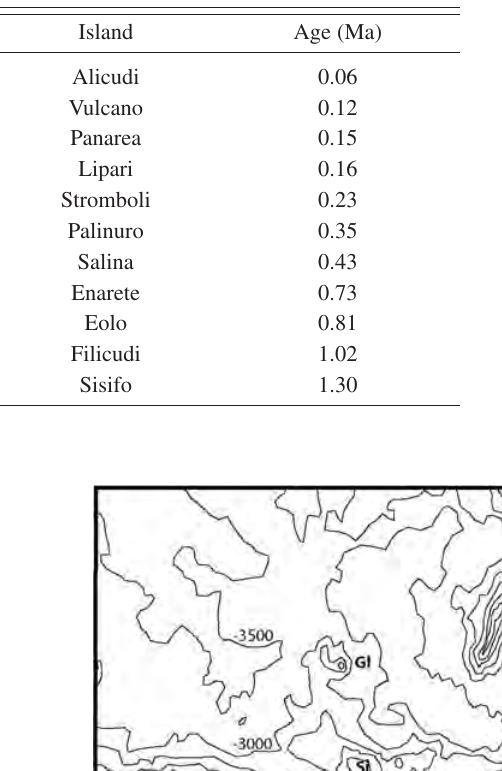
Table I. Age (Ma) of the seven Aeolian Islands and some seamounts, arranged from the youngest to the oldest (Beccaluva et al. , 1985; Kilburm and McGuire, 2001).